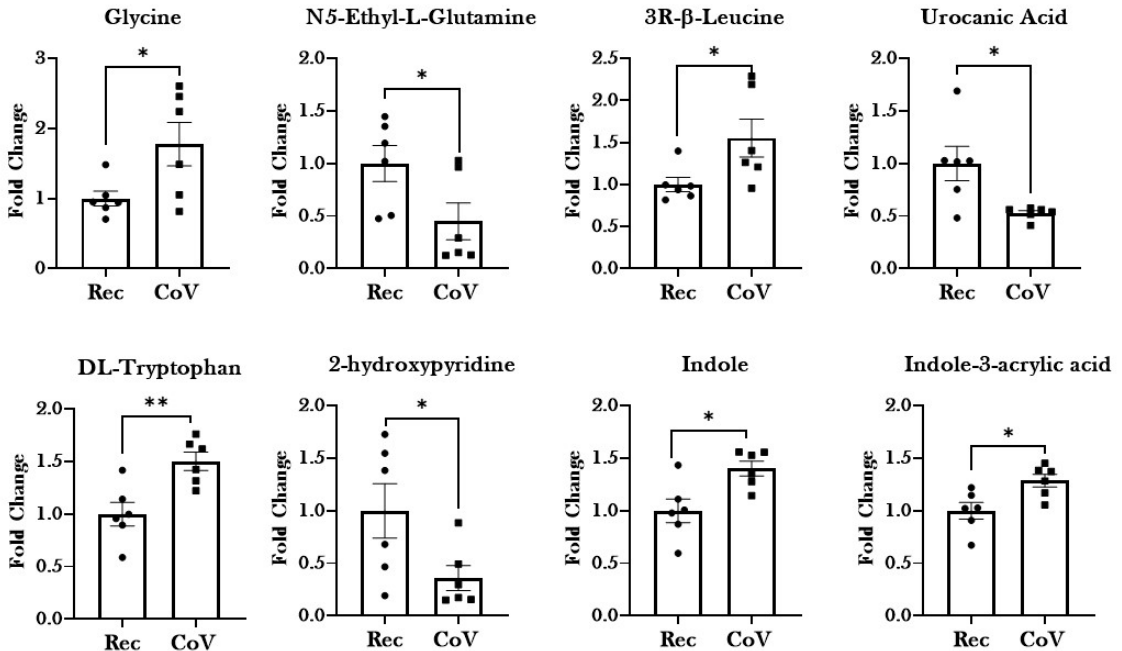
Figure 6. Dysregulation of amino acid metabolism in patients with COVID-19. Metabolomic analyses of serum samples from COVID-19-positive (CoV) and COVID-19-recovered (Rec) patients were performed using UPLC-MS. Fold changes in the levels of serum amino acids and their metabolites in CoV and Rec samples are plotted as a bar graph. Data are shown as mean ± SEM ( n = 6/group). * p < 0.05, ** p < 0.01, vs. Rec as per unpaired t